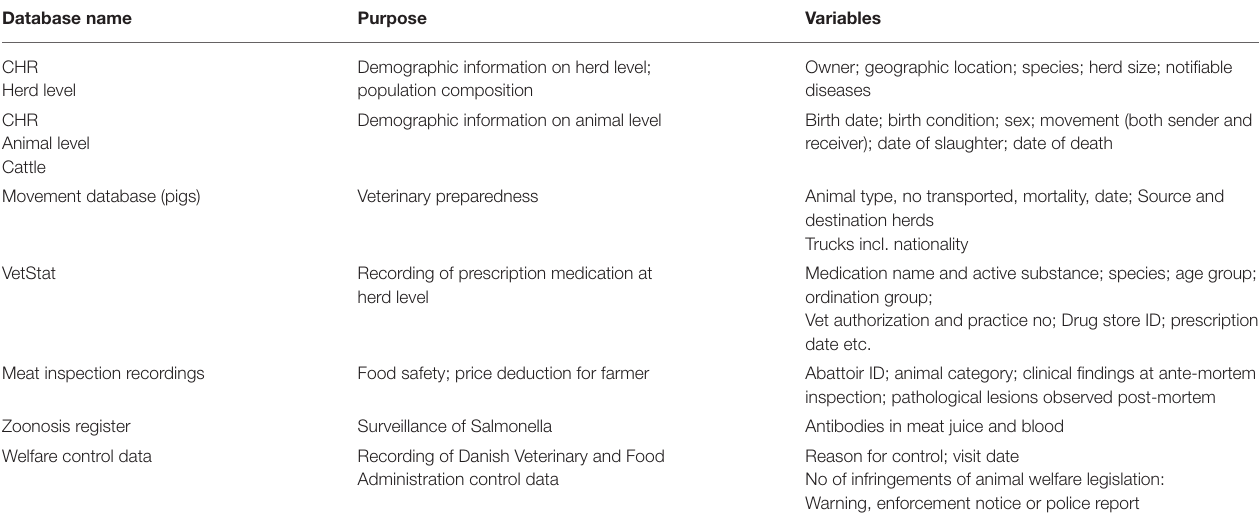
TABLE 1 | Databases on animal health embedded in Danish legislation with information publicly available.